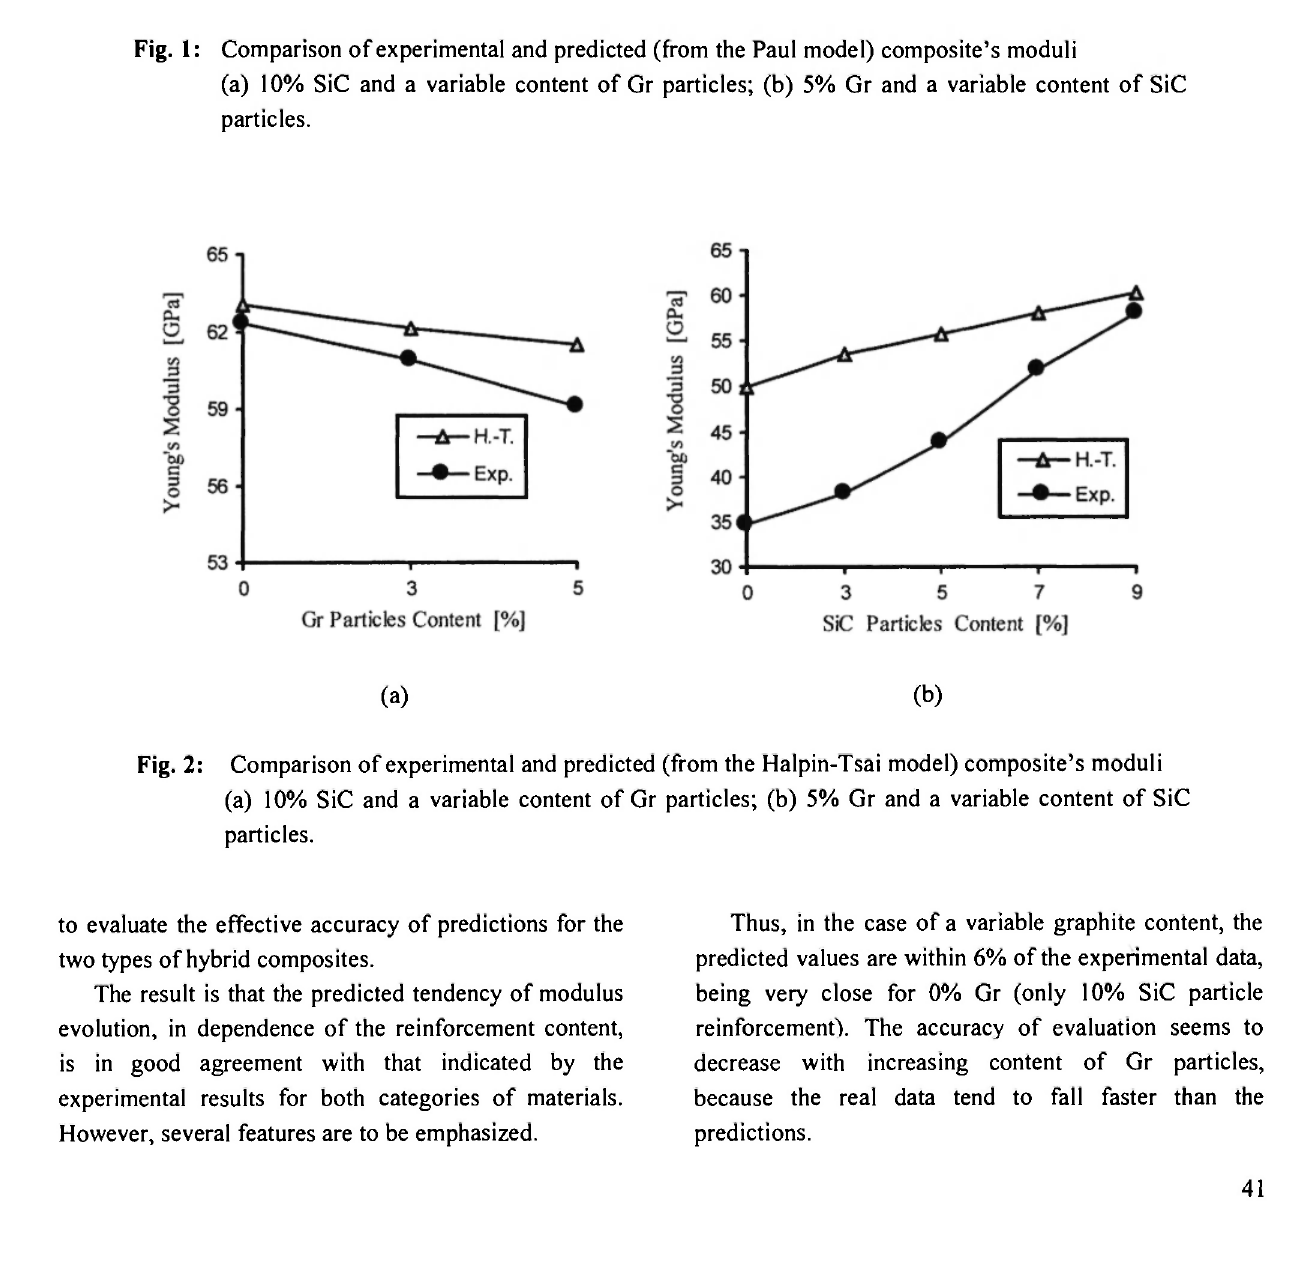
Fig. 1: Comparison of experimental and predicted (from the Paul model) composite's moduli (a) 10% SiC and a variable content of Gr particles; (b) 5% Gr and a variable content of SiC particles.